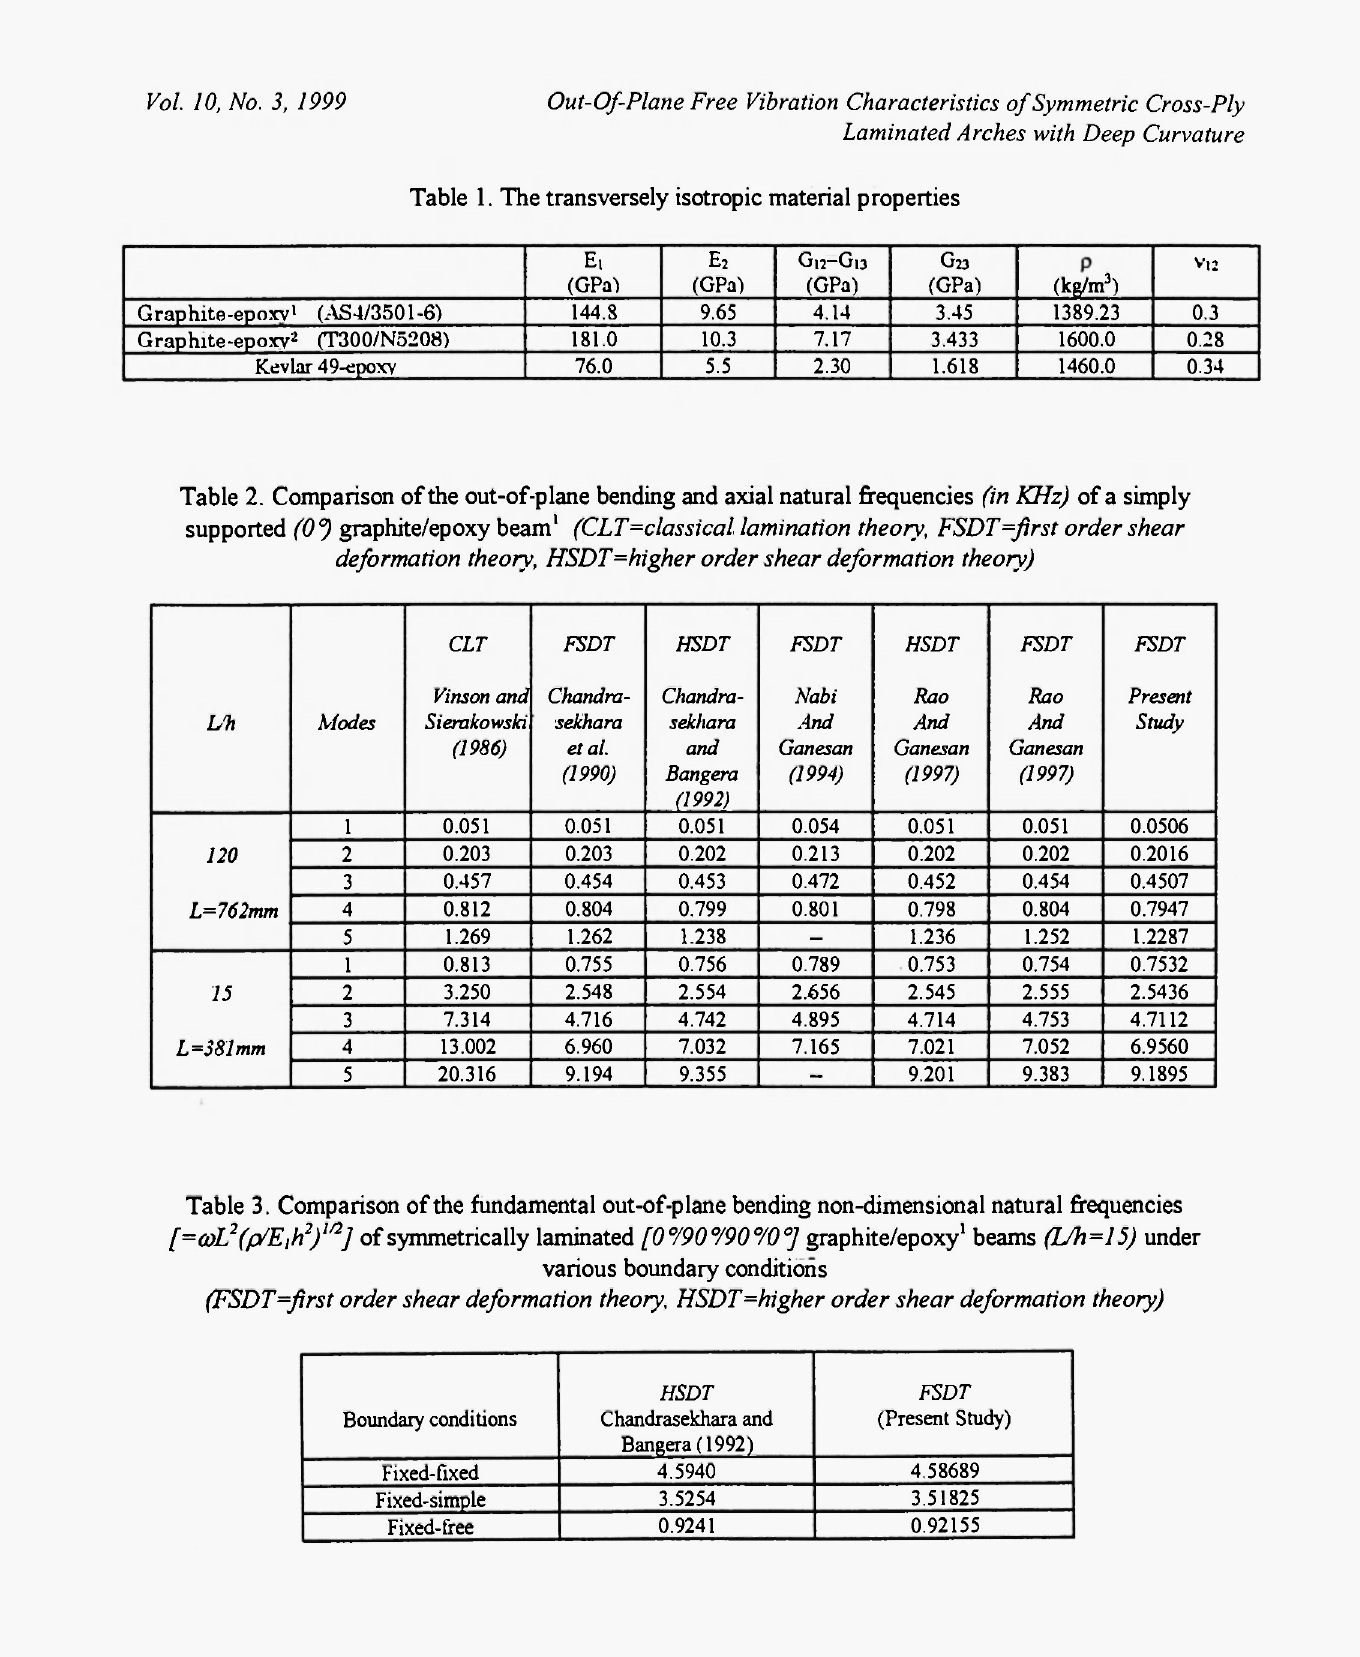
Table 1. The transversely isotropic material properties